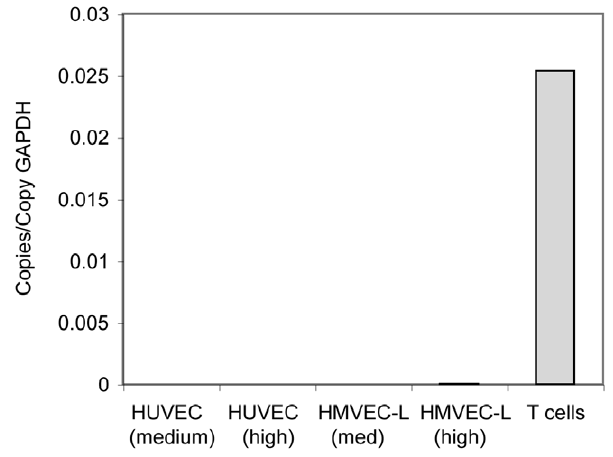
Figure 6. HUVEC and HMVEC-L have very low expression of CXCR3 mRNA. HUVEC and HMVEC-L were harvested at two different cell densities, and human peripheral blood T cells were harvested after 7 days in culture with IL-2. A primer pair in the common sequence in exon 2 of CXCR3 was used to detect both CXCR3-A and B splice variants using qPCR.